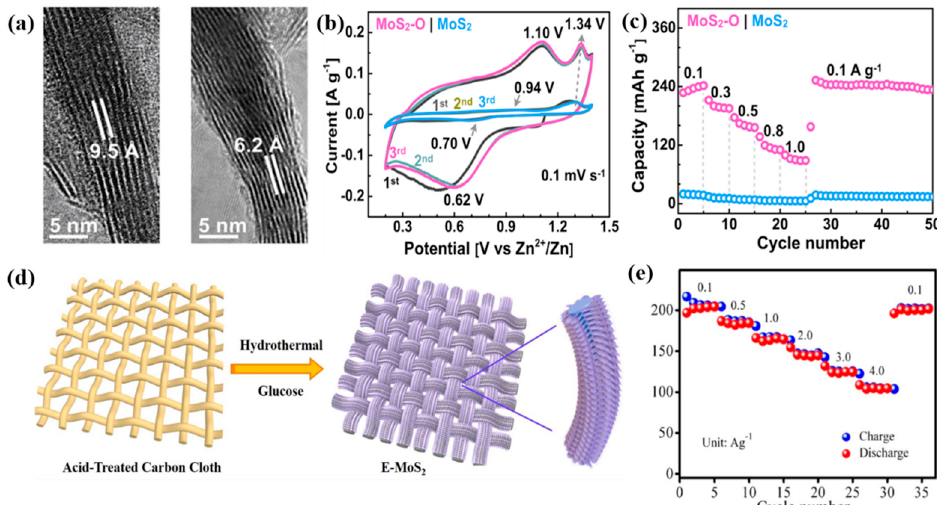
Figure 5. ( a ) Transmission electron microscopy (TEM) image of MoS 2 (left:MoS 2 with oxygen incorporation, right: bulk MoS 2 ). ( b ) cyclic voltammetry curves of MoS 2 -O (pink) and bulk MoS 2 (light blue) at a scan rate of 0.1 mV s − 1 . ( c ) Rate capability of MoS 2 -O and bulk MoS 2 at various current densities. Reprinted with permission from Liang et al. [77] Copyright 2019, American Chemical Society. ( d ) Illustration for the preparation of E-MoS 2 . ( e ) Rate capability of E-MoS 2 at various current densities. Reprinted with permission from Li et al. [78] Copyright 2018, Elsevier B.V.